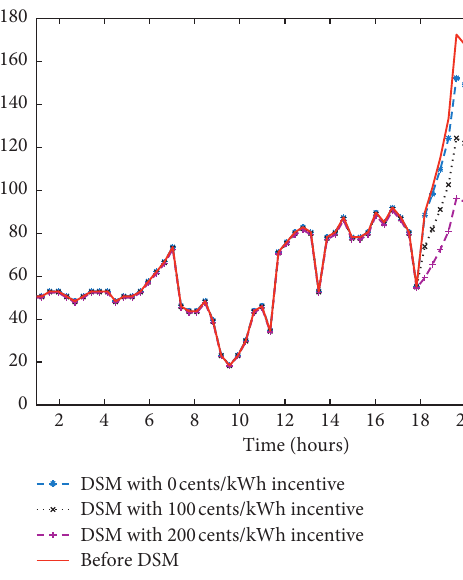
Figure 8: Load profile before and after implementation of SLR DSM with different values of